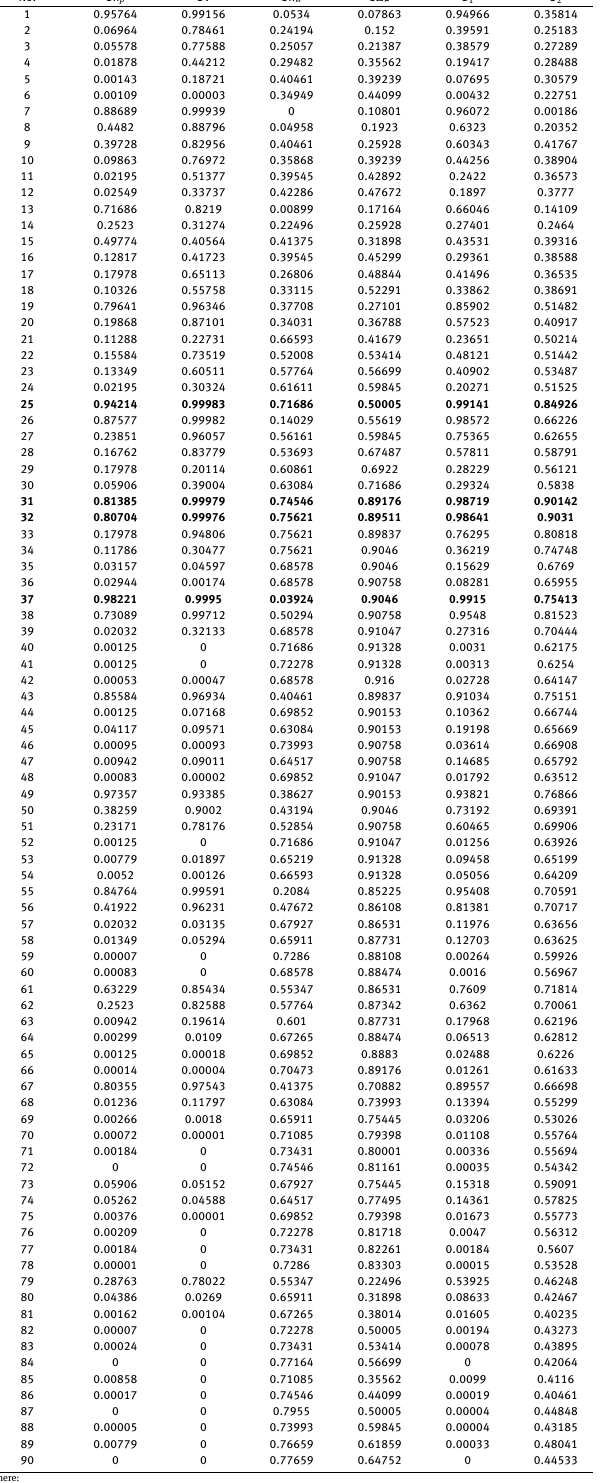
Table 4: Summary of partial and overall desirabilities for tested samples